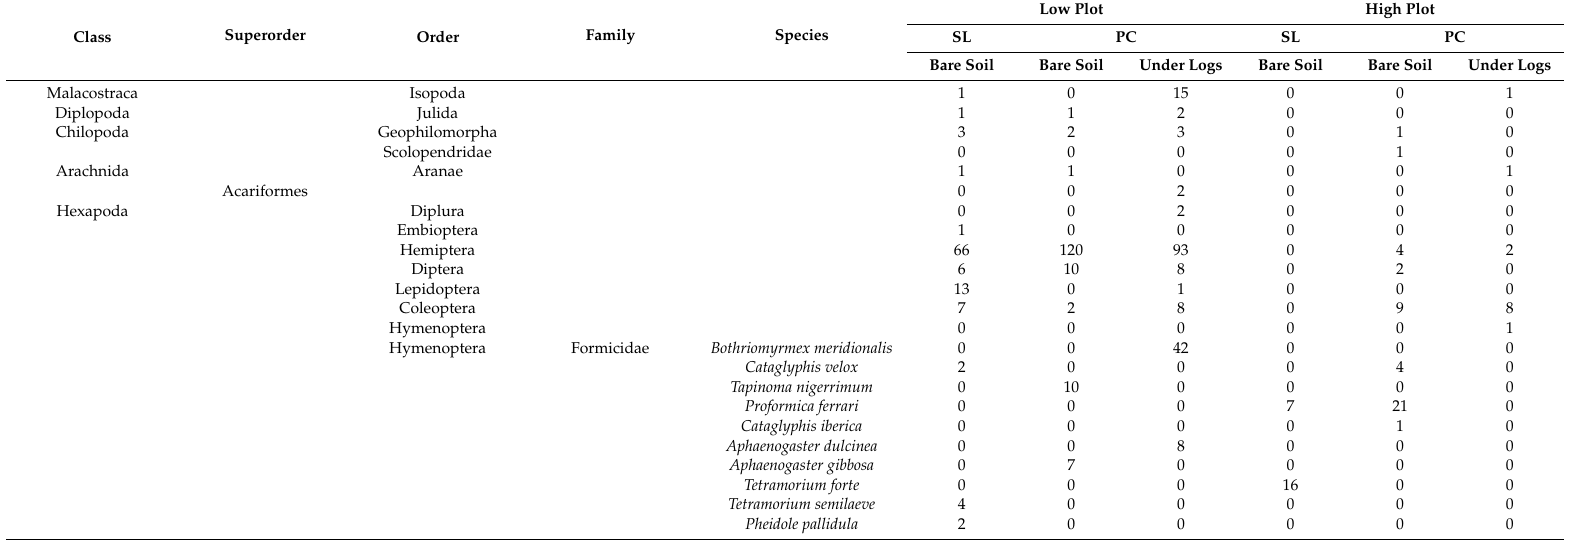
Table A1. Total number of macroarthropod individuals under two treatments (SL = Salvage logging, PC = Partial cut) and microhabitats (bare soil vs. under logs) collected at the study site ten years after post-fire dead-wood